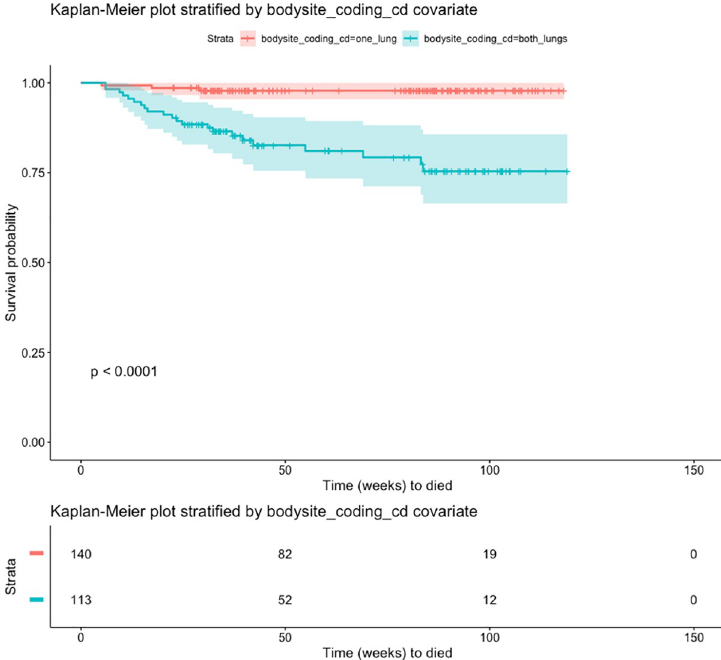
Fig 1. Kaplan-Meier curve showing probability of survival over time stratified by occurrence of radiologist observation in both lungs and only one lung. Shaded area reflects the 95% confidence interval of each survival curve. The table show the number of cases at each time point. P-value shows the log-rank test comparing all survival